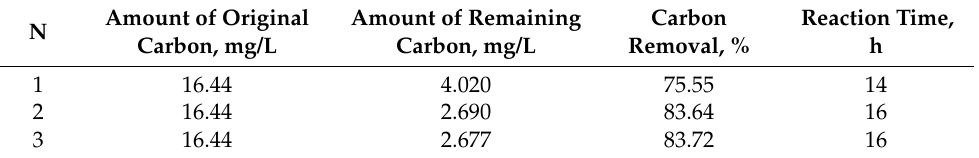
Figure 19. UV-Vis spectra of DB15 decolourization at 40 mg/L, catalyst 1 g/L, natural pH, and light intensity 11.2 W/m 2 . Table 9. DB15 mineralization at dye concentration 40 mg/L, natural pH, catalyst 2 g/L, light intensity 11.2 W/m 2 , and treated volume 200 mL.